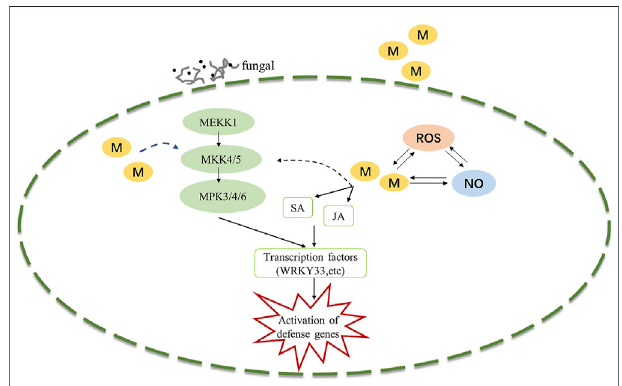
FIGURE 6 | Potential model illustrating the melatonin induced defense signaling in Lilium against B. elliptica . B. elliptica infection or exogenous melatonin application induced activation of MAPK cascades and NO accumulation, which in turn activates defense related genes. Abbreviation: ROS, reactive oxygen species; MAPK, Mitogen-activated protein kinase; NO, nitric oxide; SA, salicylic acid; JA, jasmonic acid; M,